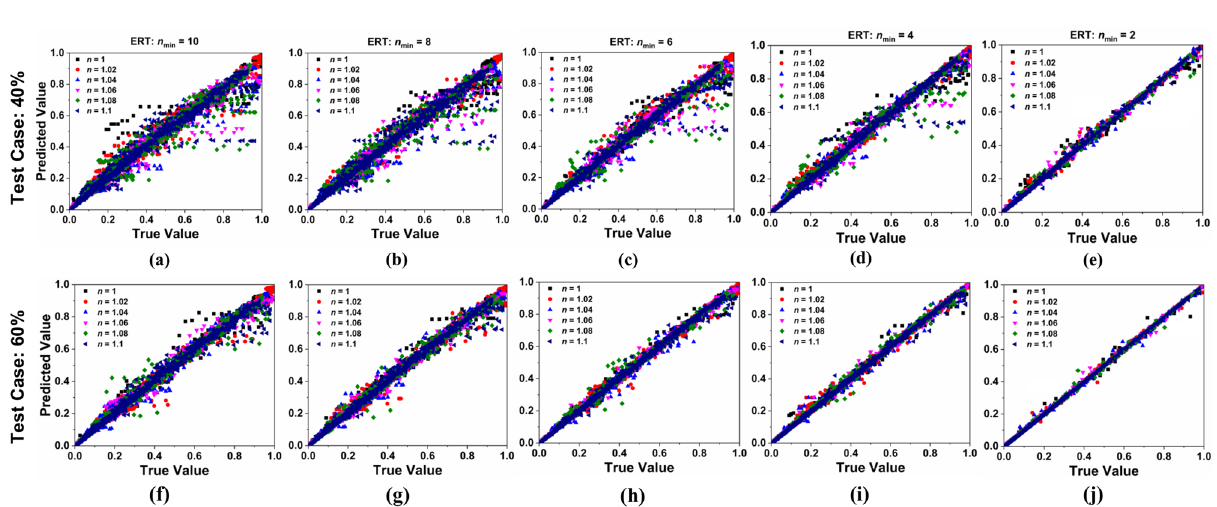
Figure 11. Values of absorption predicted by ERT model vs simulated values of absorption for various refractive index ( n ) values ( a ) n min = 10 for TC-40 ( b ) n min = 8 for TC- 40 ( c ) n min = 6 for TC- 40 (d) n min = 4 for TC- 40 ( e ) n min = 2 for TC- 40 ( f ) n min = 10 for TC- 60 ( g ) n min = 8 for TC- 60 ( h ) n min = 6 for TC- 60 ( i ) n min = 4 for TC- 60 and ( j ) n min = 2 for TC-